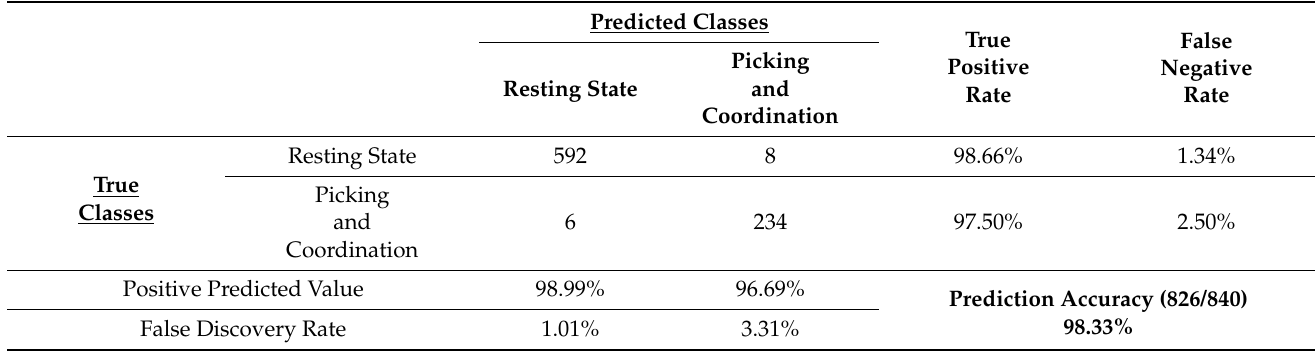
Table 2. Binary classification results—random forest using bag of node degrees.